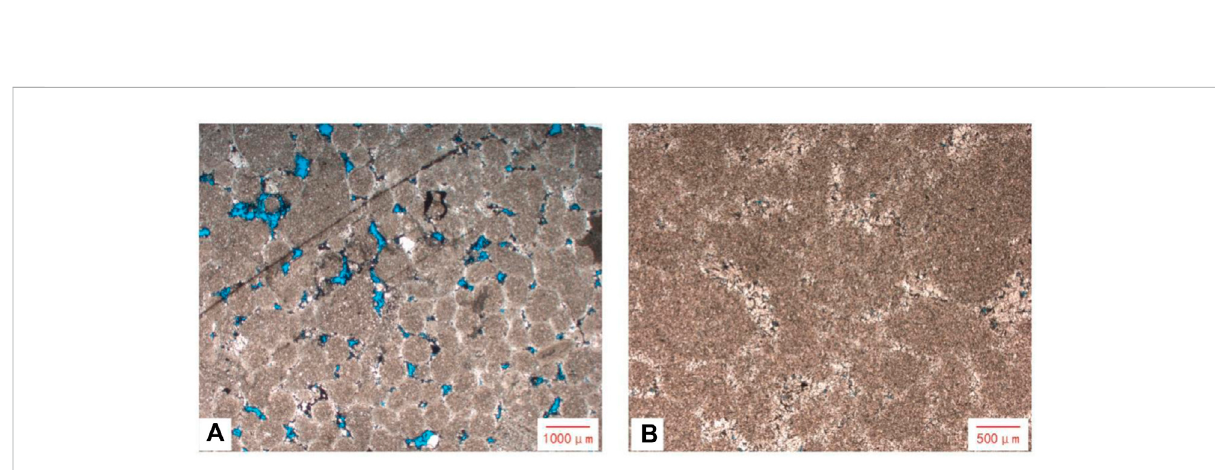
FIGURE 5 Microscopic characteristics of different types of granular pores in the Longwangmiao Formation in the study area. (A) Oolitic dolomite pores, GS6, 4546.78 – 4546.88 m, single polarized light; (B) Sandy dolomite pores, GS17, 4505.2 m, single polarized